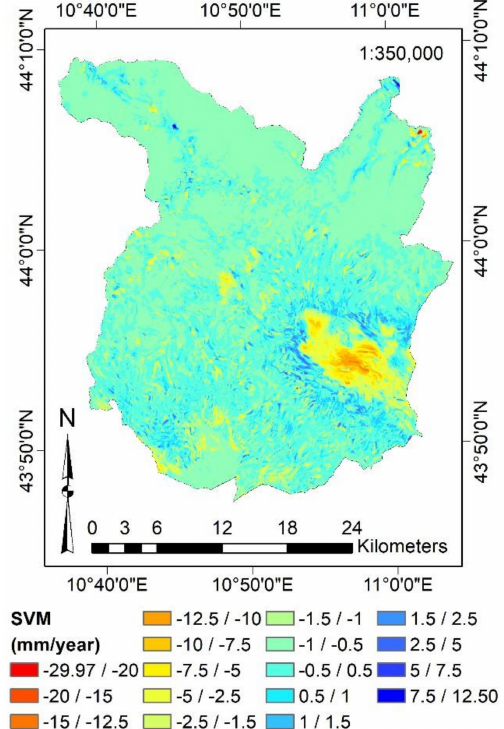
Figure 7. Surface motion mapping over the study area by SVM. The present figure has been adapted from Fiorentini et al.